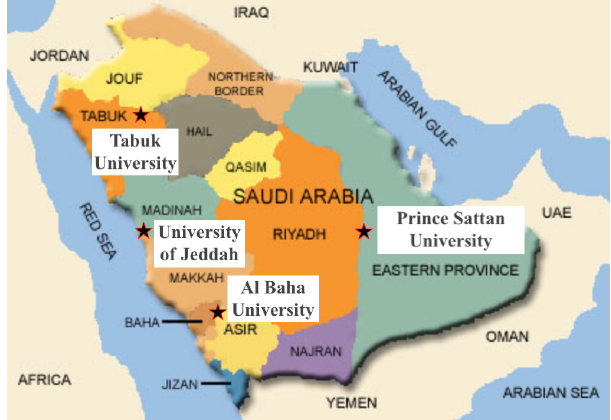
Figure 4: Map of the four considered universities at KSA.